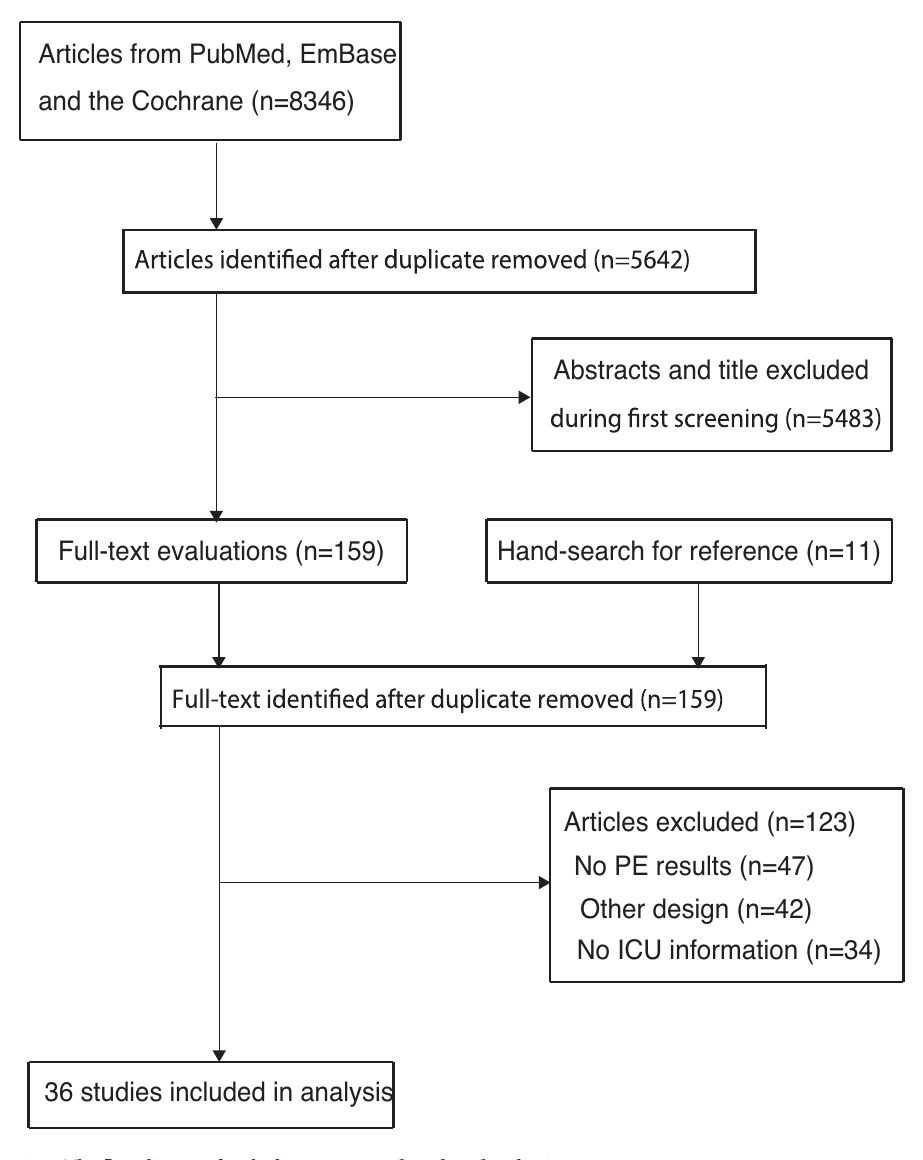
Fig 1. The flow diagram for the literature search and study